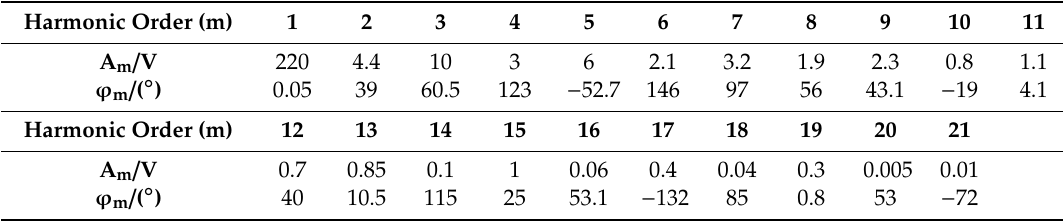
Table 4. Parameters of the simulated